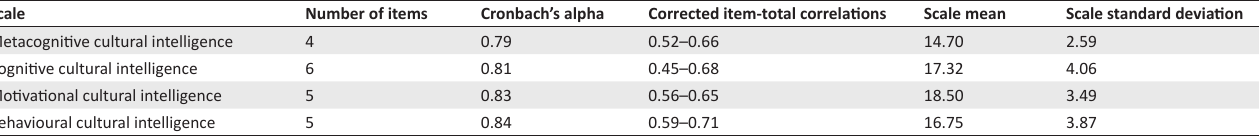
TABLE 1: Reliability analysis, scale mean and standard deviation output for the cultural intelligence scale dimensions. Scale Number of items Cronbach’s